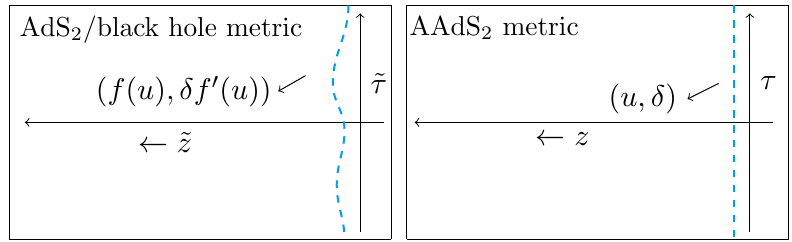
Figure 2 . The picture in the right panel (asymptotically AdS 2 metric with straight boundary) is achieved by performing large di(cid:11)eomorphisms (4.9) on the left panel (AdS 2 /AdS 2 black hole metric with wiggly